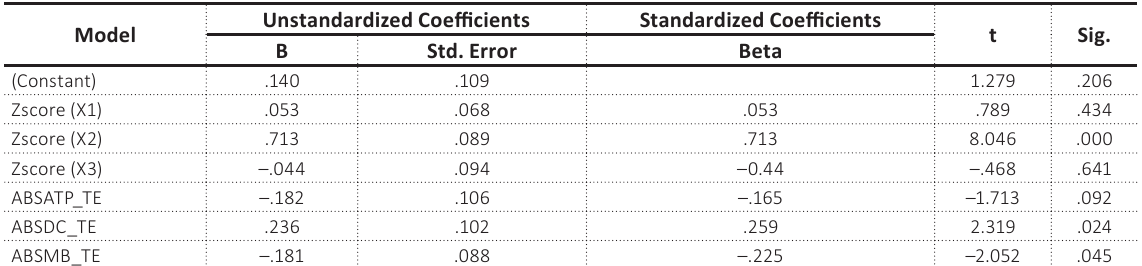
Table 4. Absolute difference value test